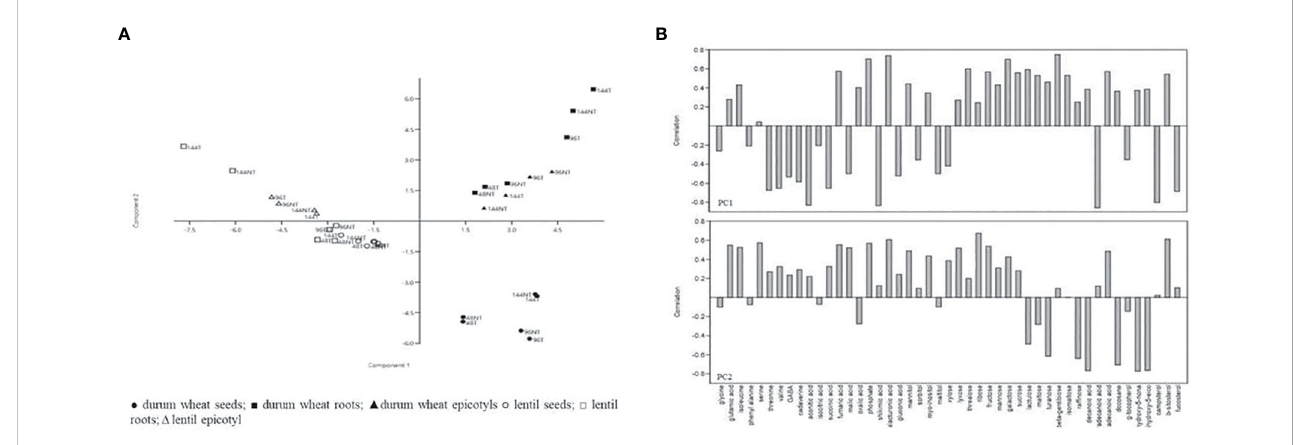
FIGURE 2 PCA analysis of combined dataset of the two species. (A) the score plot of the fi rst two PCs; (B) correlation of metabolites to PC1 and